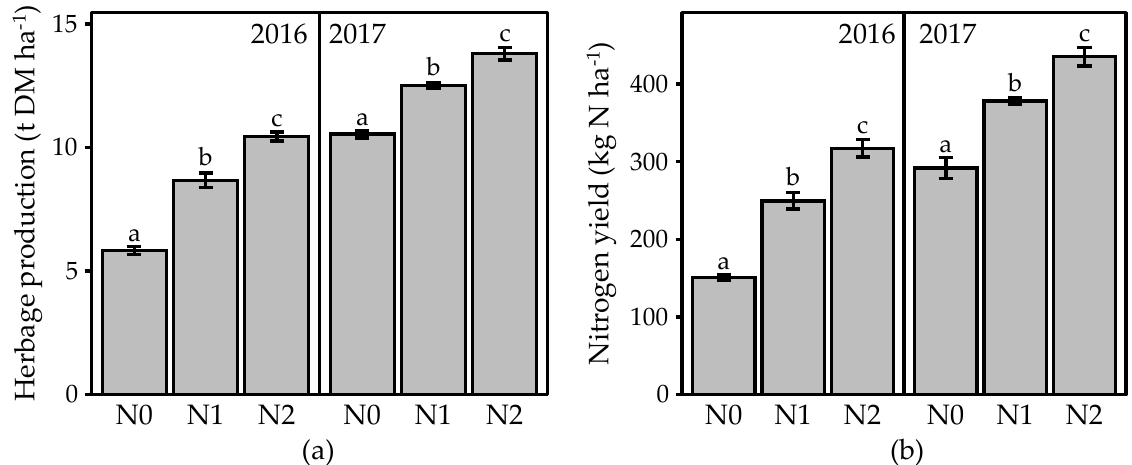
Figure 1. ( a ) Annual herbage dry matter production and ( b ) nitrogen yield in 2016 and 2017 for three N application rates (0 (N0), 140 (N1) and 280 (N2) kg N ha − 1 ). Mean values with different superscripts differ between N application rates ( p ≤ 0.05).